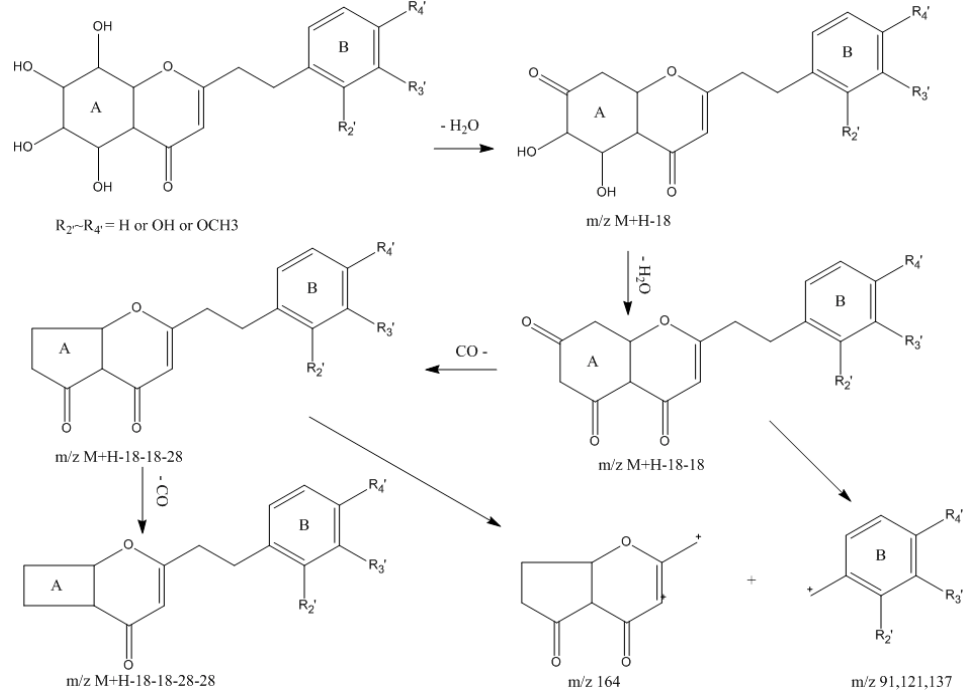
Figure 2. Proposed main fragmentation pathway of 5,6,7,8-tetrahydro-2-(2-phenylethyl)chromones. Peaks 62 and 63 at m / z 335 (C 17 H 18 O 7 ) were assigned to aquilarone F isomers by comparing molecular ion and fragments ions of agarotetrol (319 + 16), while peaks 67 and 71 were tentatively attributed to 5,6,7,8-tetrahydroxy-2-(4-methoxyphenethyl)-5,6,7,8-tetrahydrochromone [11,21]. Peak 61 at m / z 365 (319 + O + OCH 2 ), based on the agarotetrol skeleton, was tentatively characterized as aquilarone A